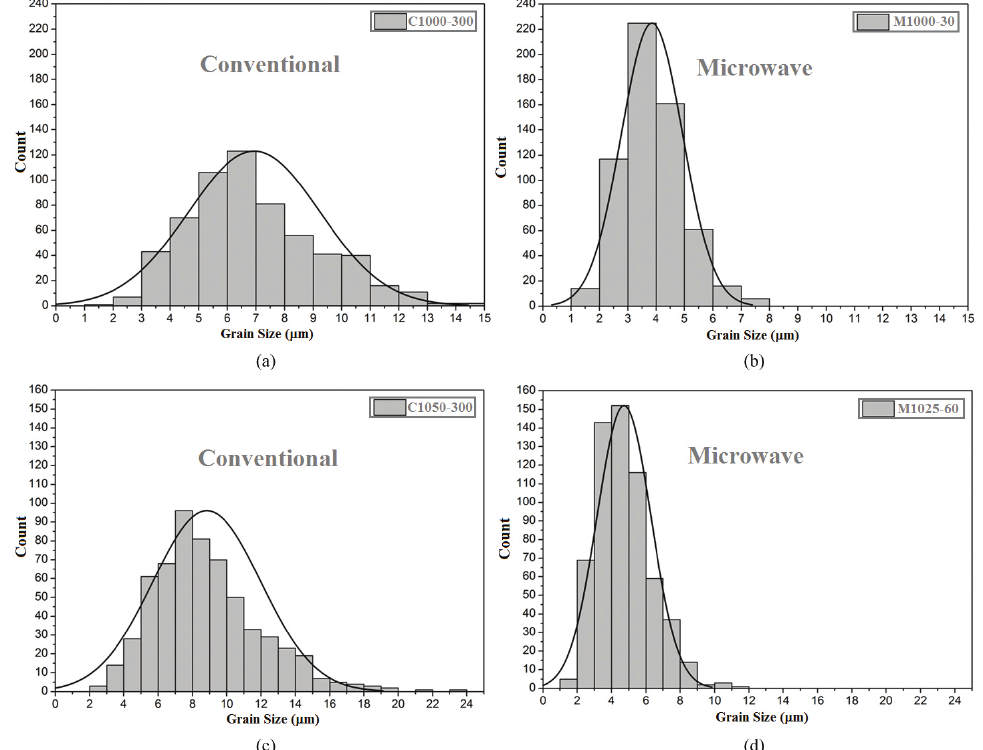
Figure 6. Grain size distribution for the samples C1000-300 (a), M1000-30 (b), C1050-300 (c) and M1025-60